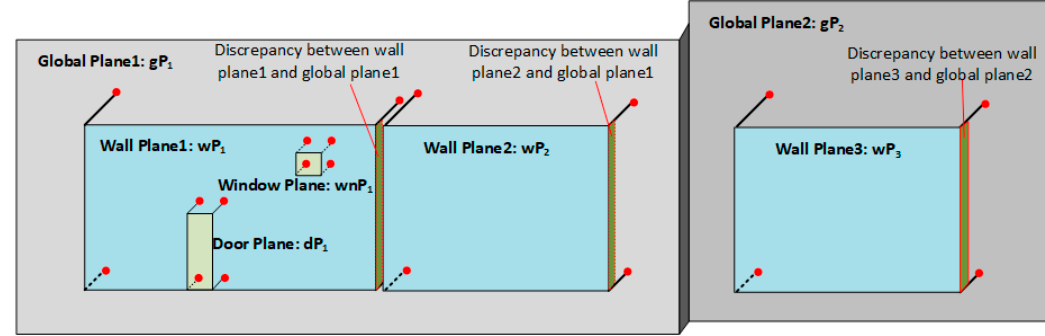
Figure 10. Strategy of global optimization for planes.